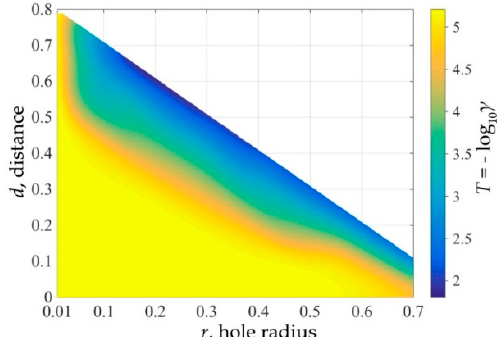
Figure 4. Dependence of the threshold 𝛾 for the mode (11, 1, 𝑒 ) on the relative distance 𝑑 between the centers of the cavity and the hole and the relative radius 𝑟 of the hole.